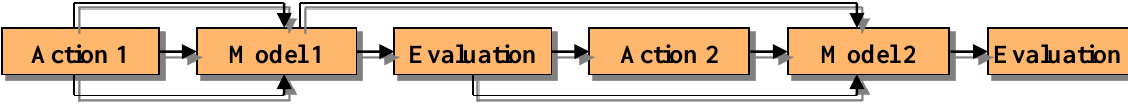
Fig. 1. Chain of actions as “activity tacts” according to Amosov N.M.